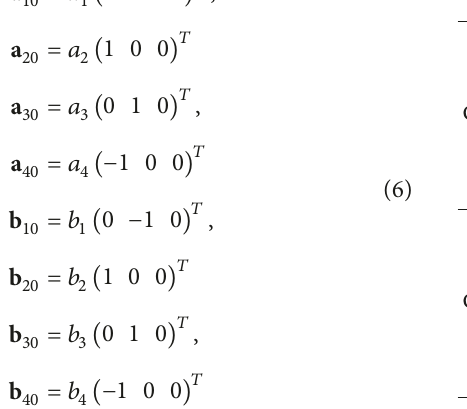
Table 1: Mechanism analysis of the inverse